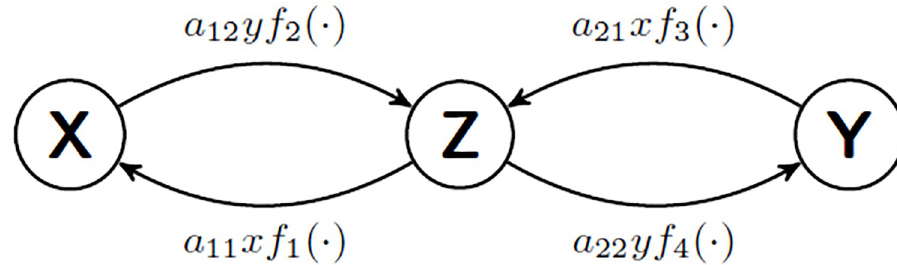
Fig 1. Markov chain emerging from the generic form of